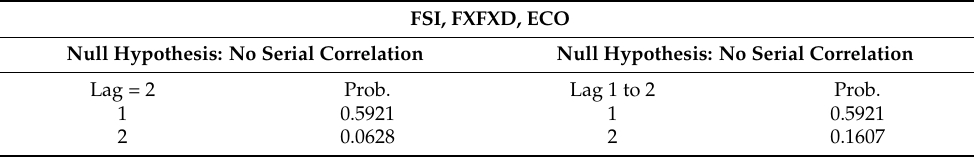
Table 9. VAR residual serial correlation.